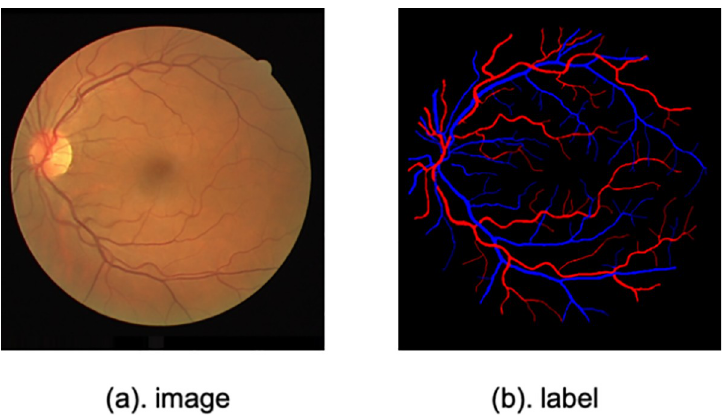
Fig 7. A sample retinal image from the DRIVE dataset and its corresponding artery/vein segmentation map.